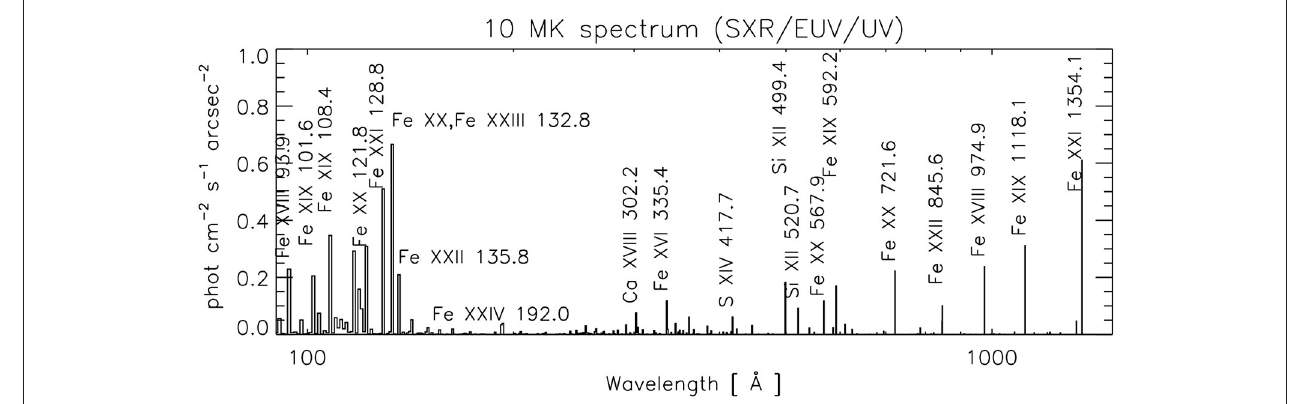
FIGURE 1 | A simulated CHIANTI version 9 isothermal spectrum at 10 MK. Note that the spectrum has a bin size of 1